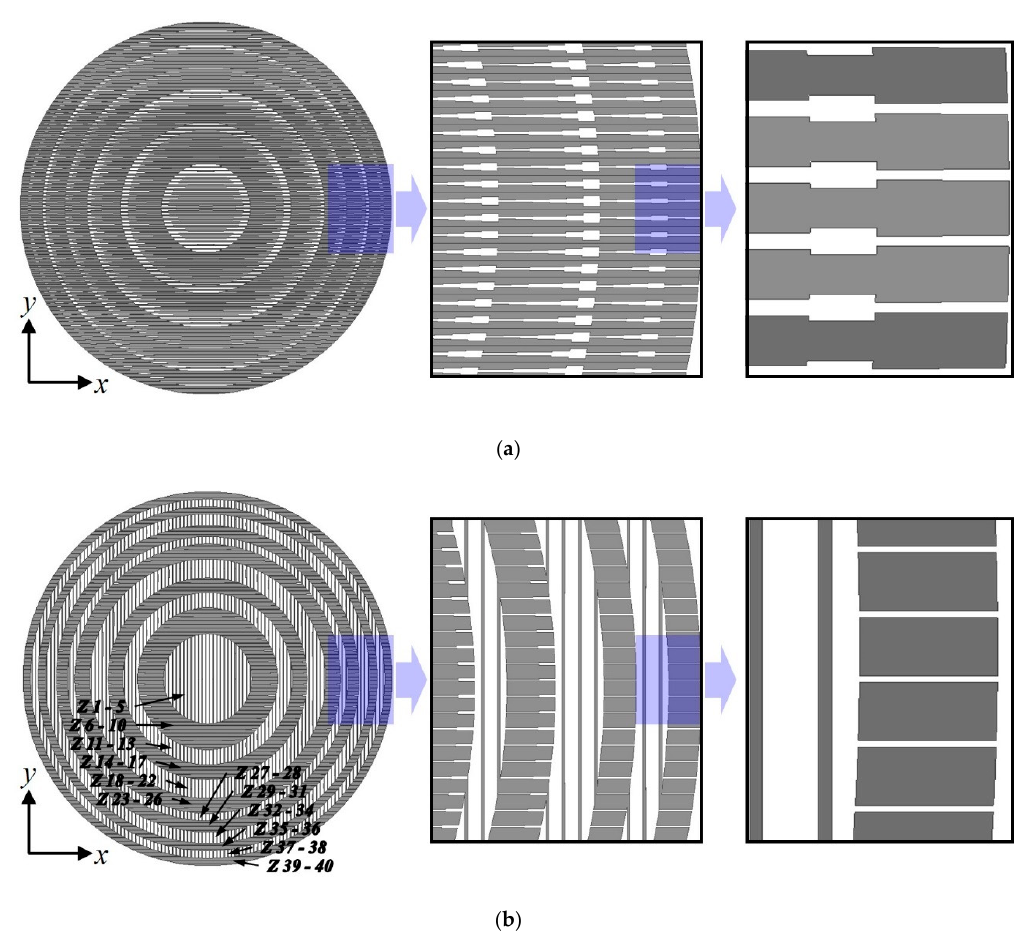
Figure 11. Top views and their zoomed views of ( a ) first and ( b ) second metal layers configured using coplanar capacitive and inductive strips. Table 2. Numbered zones, required phase shift at the center of each zone, selected UC# for each zone, incident angle, insertion loss and phase at the center of each zone.